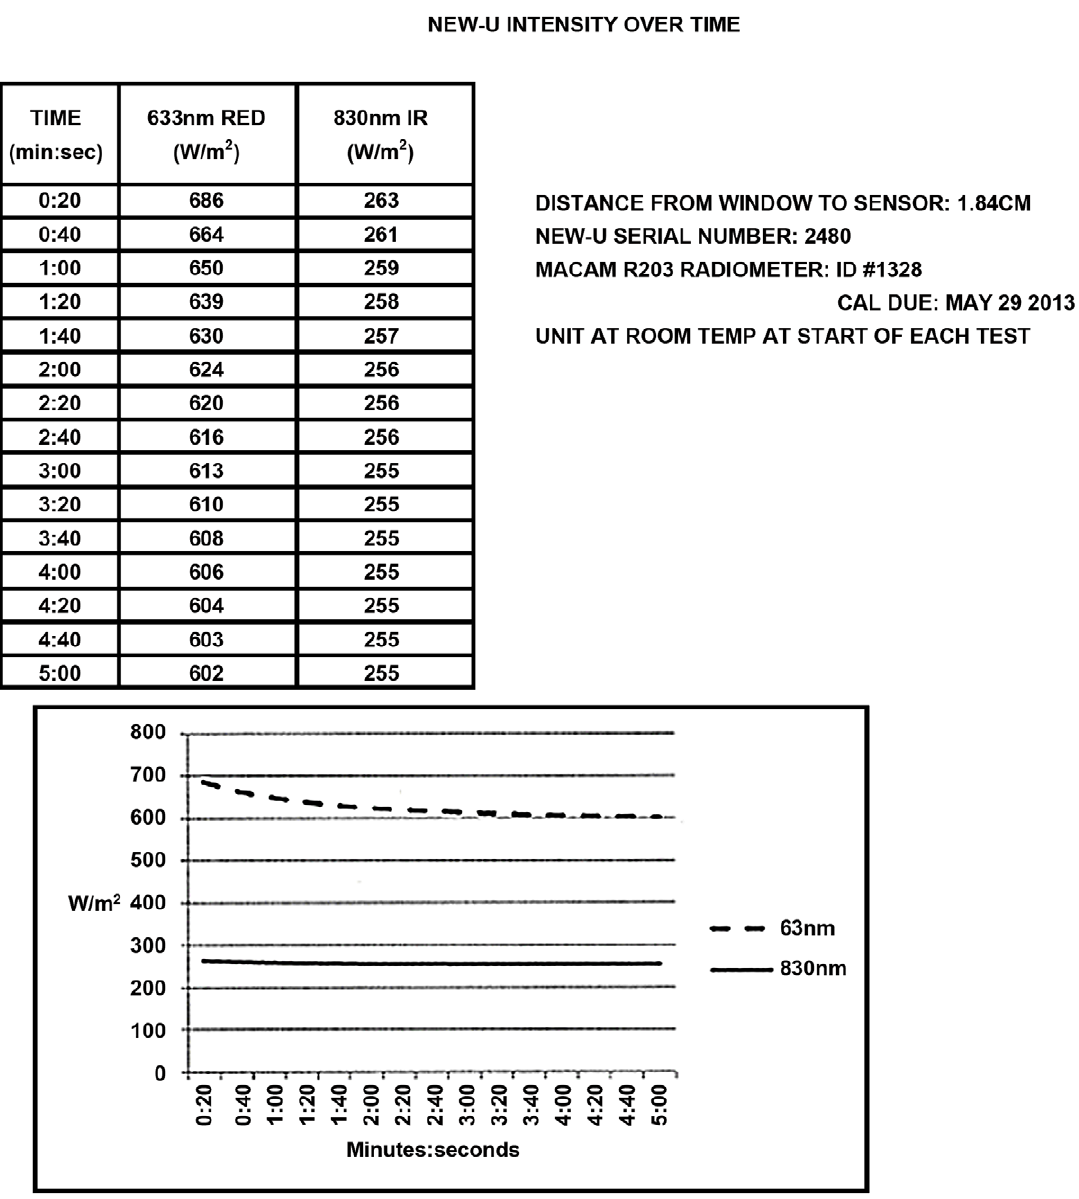
Figure 1. LED Stability Performance for Red and Near Infrared Light over 5 minutes. Output of red light and near infrared light from the LED device is relatively stable over